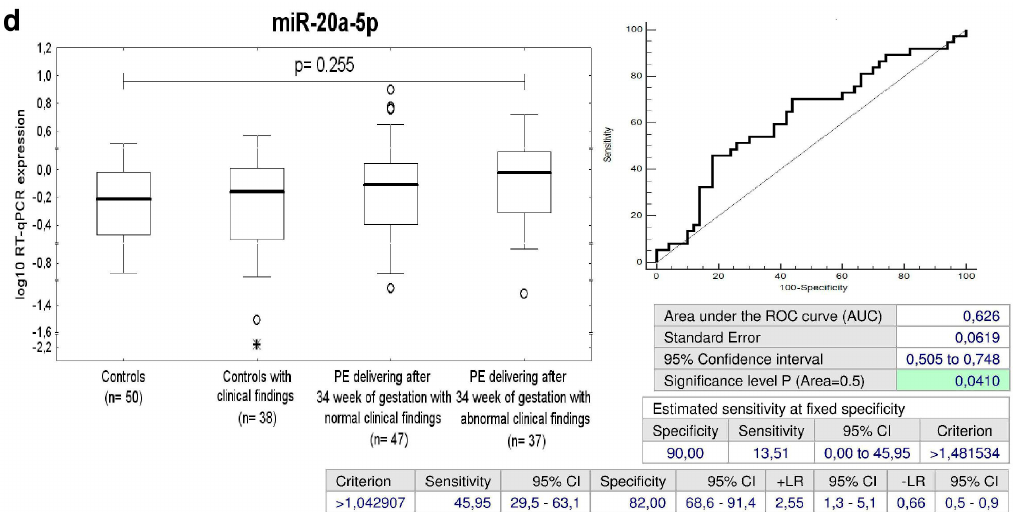
Figure 10. Postnatal microRNA expression profile in children with abnormal postnatal clinical findings descending from PE pregnancies. ( a ) Increased expression of miR-1-3p was found in children with abnormal postnatal clinical findings exposed to late PE; ( b , c ) Increased expression of miR-103a-3p was observed in children with abnormal postnatal clinical findings exposed to severe PE or late PE; ( d ) Increased expression of miR-20a-5p was found in children with abnormal postnatal clinical findings with a prior exposure to late PE.